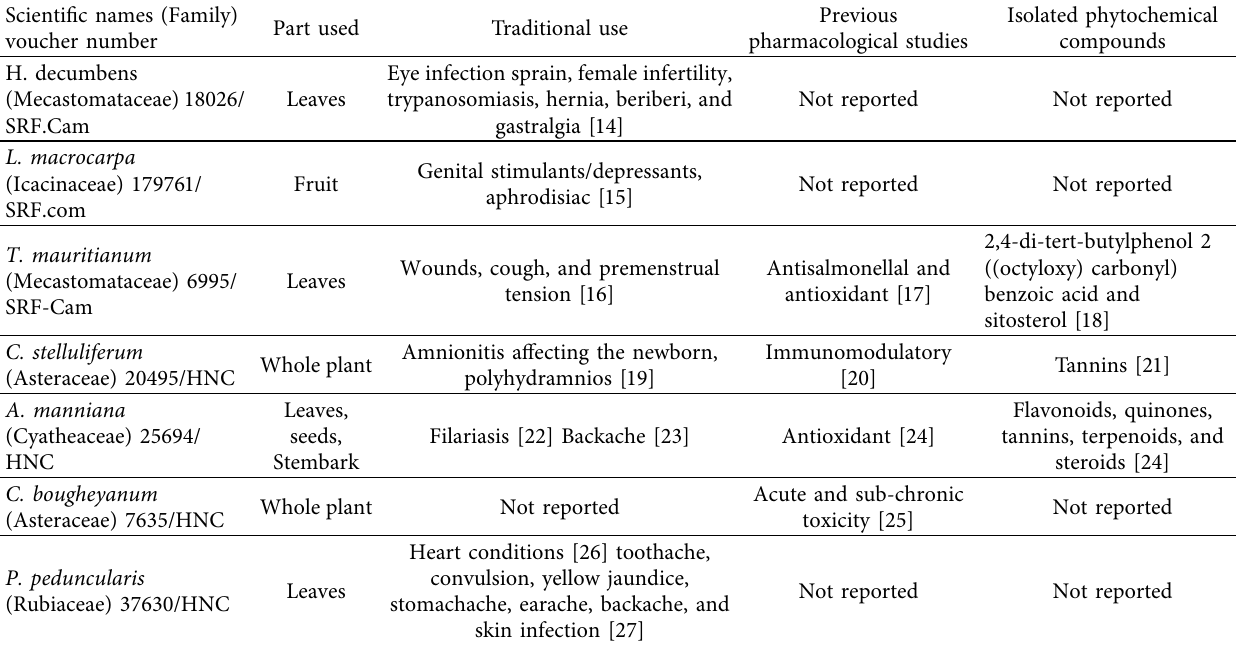
Table 1: Characteristics of the medicinal plants investigated in this